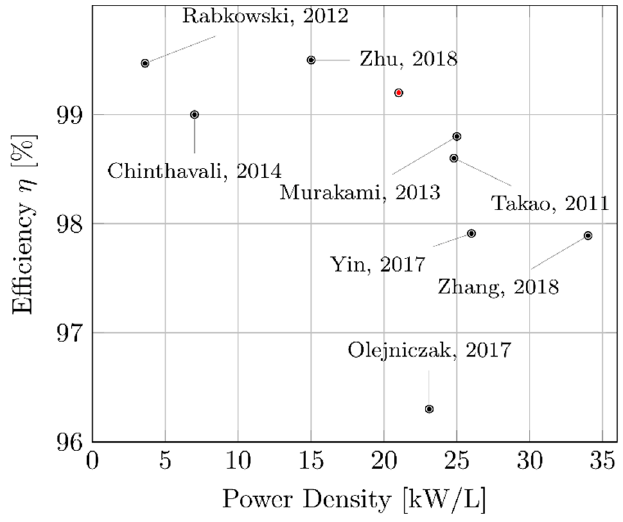
Figure 1. Map of efficiencies vs. power densities for inverters using SiC MOSFETs with the inverter developed to validate this work marked in red [9–17].